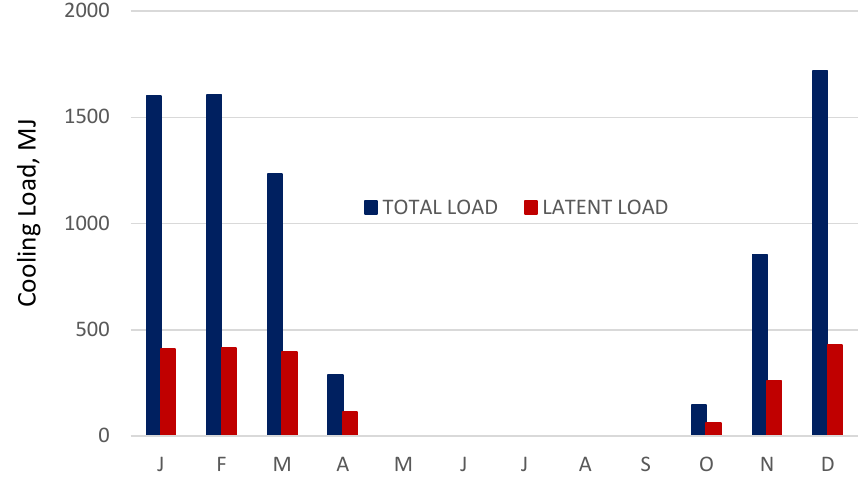
Figure 10. Monthly total and latent cooling demands for the house (normal operation).